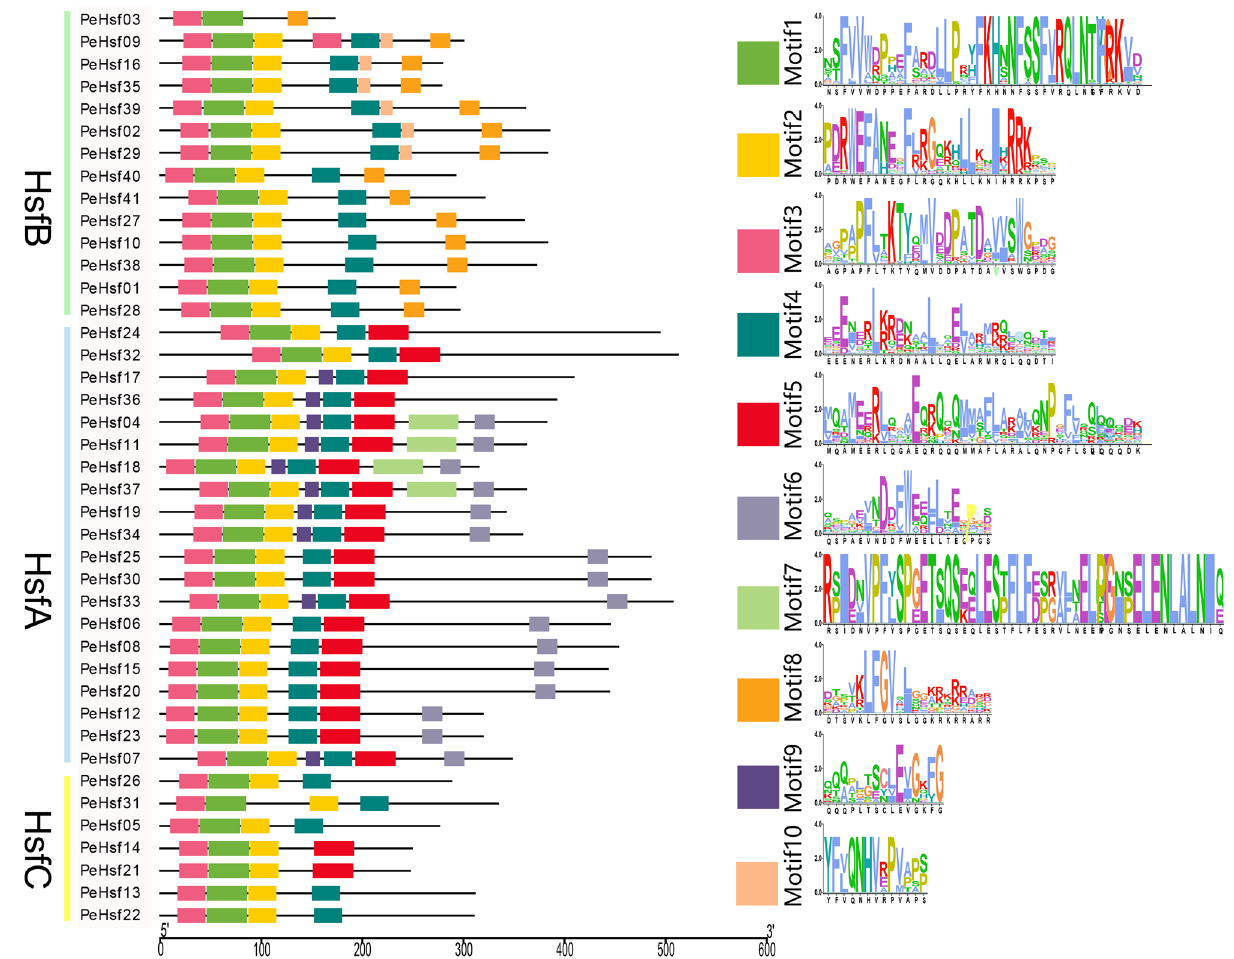
Figure 4. Distribution of conserved motifs of HSF proteins from moso bamboo. The scale bar at the bottom indicates the protein lengths, and sequence logos for each conserved motif are shown at right. TBtools (v1.0697) (https:// github. com/ CJ- Chen/ TBtoo ls/ relea ses): Visualize MEME/MAST Motif pattern for visualization. The XML file obtained by the MEME online tool is obtained by visualizing the Batch MEME Motifs Viz plugin in TBtools